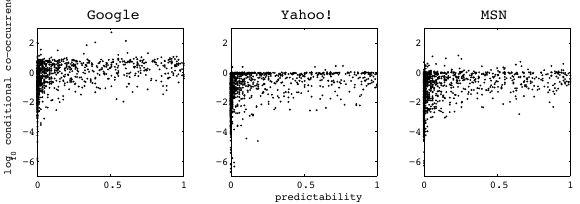
Figure 1. Conditional co-occurrence probability plotted against predictability for words in the Potsdam Sentence Corpus. Words that only rarely co-occur with their context tend to be unpredictable. Note that some of the results show conditional co-occurrence probabilities greater than one (or equivalently, the logarithm greater than zero); this anomaly occurs because we directly use the frequency estimates produced by the search engines, which exhibit both noise and systematic errors.